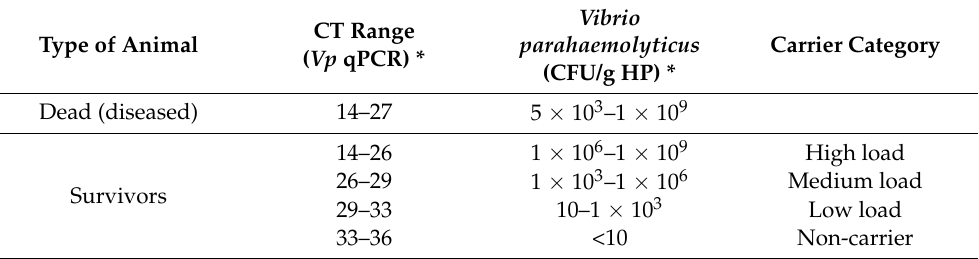
Table 5. Categories of carrier animals according to Vibrio parahaemolyticus load in hepatopancreas (HP). CT range and equivalences in CFU/g in HP from diseased/dead and survivor animals.